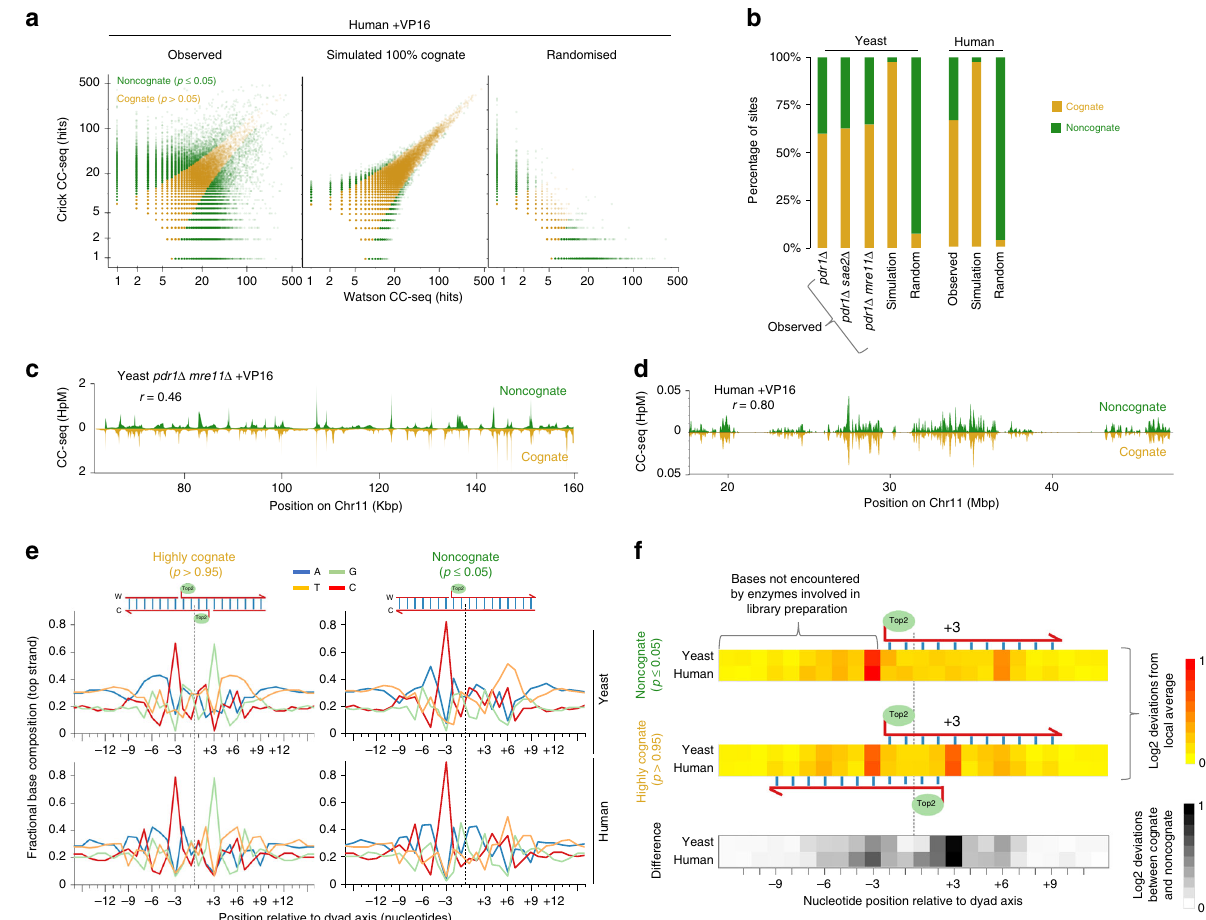
Fig. 6 Local DNA sequence composition deviations associated with cognate and noncognate CC-seq sites. a Scatterplots of human TOP2 CC-seq hits on the Watson strand vs the Crick strand at each 3 bp offset site, in: observed data; a dataset sampled from a simulation where all 3 bp offset sites had identical Watson and Crick values ( ‘ 100% cognate ’ ); randomised observed data where Crick hits were shuf fl ed. Noncognates (green) and cognates (gold) were de fi ned as those 3 bp offset sites with signi fi cantly different, or not signi fi cantly different Watson and Crick hits, respectively (two-sample, two-tailed Poisson test; p ≤ 0.05). Sites with fewer than eight hits in total (Watson + Crick) were excluded due to insuf fi cient statistical power. b Percentage of Top2 CC-seq sites that were classed cognate vs noncognate in: observed, simulated 100% cognate, and randomised as de fi ned in ( a ) for S . cerevisiae and human VP16-treated samples. S . cerevisiae cognate simulation and randomisation use pdr1 Δ mre11 Δ dataset. c , d Cognate (gold) and noncognate (green) Top2 CC- seq signal from VP16-treated pdr1 Δ S . cerevisiae cells ( c ) or RPE-1 cells ( d ), within example regions. The data were smoothed according to local density ( c ), or binned at 10 Kbp resolution and smoothed with a sliding 10-bin Hanning window ( d ). e Average nucleotide composition over a 32 bp window centred on the highly cognate ( p > 0.95) or (inferred) noncognate ( p ≤ 0.05) Top2 dyad axis, in VP16-treated pdr1 Δ mre11 Δ S . cerevisiae and human RPE-1 cells. Values reported are for the top strand only. f Heatmaps of nucleotide composition deviations from the local average, for noncognate (top) and highly cognate (middle) sites; and the difference between the two (bottom). For the upper two panels, the absolute log 2 deviations of the four nucleotides were summed at each position, and are expressed on a colour-scale from yellow to red. For the bottom panel, the absolute log 2 fold difference between highly cognate and noncognate were summed at each position and are expressed on a colour-scale from white to black. HpM Hits per million mapped reads per base remained preferentially associated with intergenic DNA (Supple- mentary Fig. 10d) and were enriched upstream of TSSs (Supplementary Fig. 10e), whilst human noncognate sites remained preferentially associated with compartment A (Supple- mentary Fig. 11c) and positively correlated with transcription (Supplementary Fig. 11d).